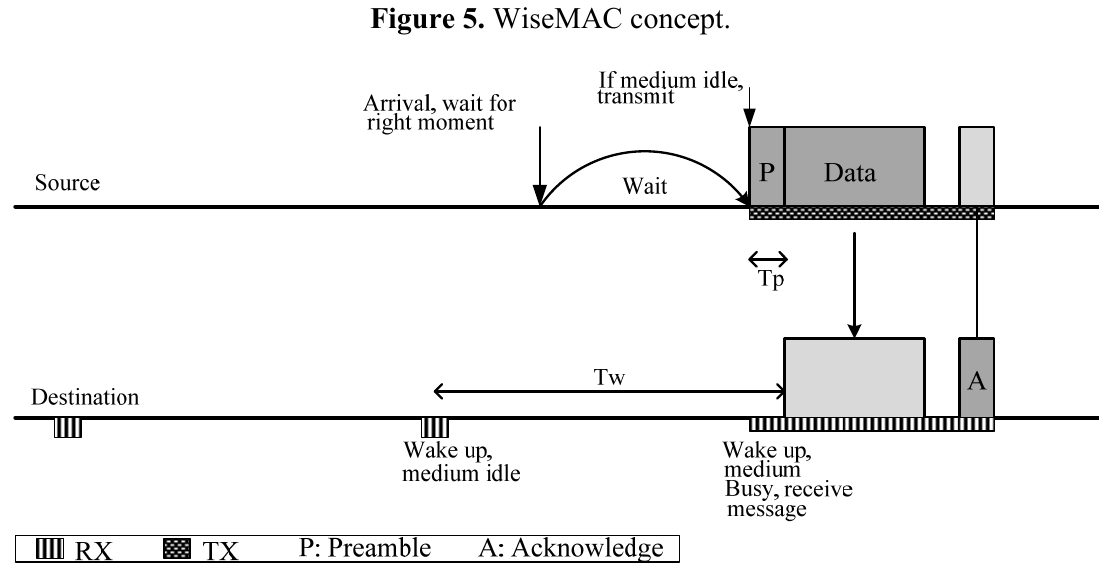
Figure 5. WiseMAC